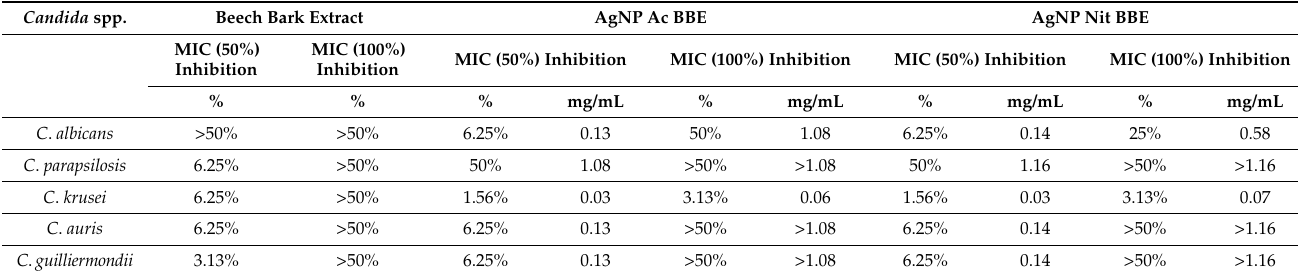
Table 1. Antifungal activity of beech bark extract and AgNP BBEs against Candida spp. Candida